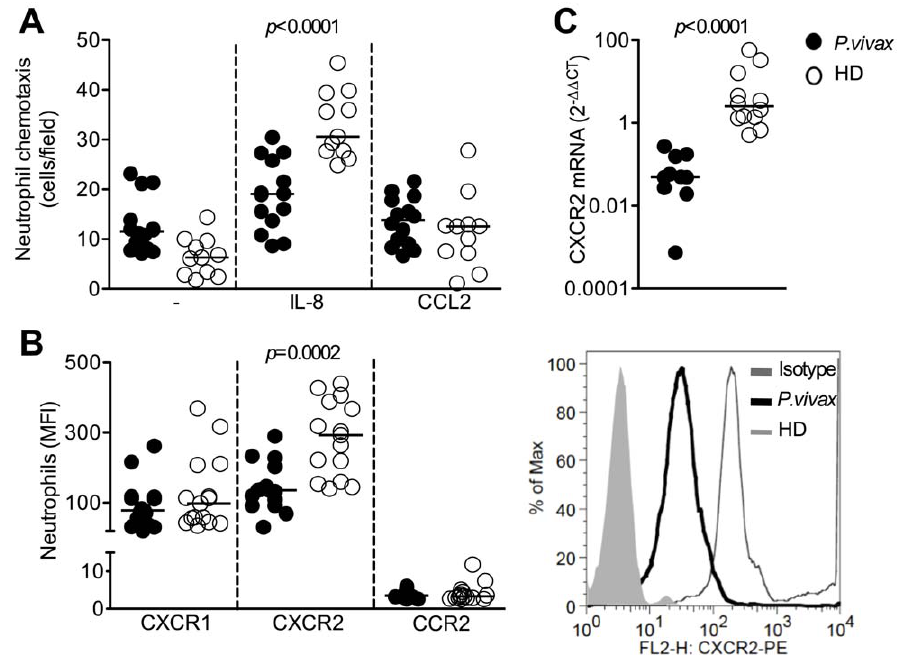
Figure 5. Malaria impairs neutrophils response to CXCR1 and CXCR2 ligand. Neutrophils were isolated from P. vivax -infected patients (closed circles; n=15) or healthy donors (open circles; n=15), and chemotaxis towards IL-8 (CXCL8) and CCL2 was assessed (A). MFI of CXCR1, CXCR2 and CCR2 on neutrophils were evaluated by flow cytometry and representative histograms of CXCR2 expression are shown (B). CXCR2 message was measured by qPCR (C). Significant differences are indicated with p -values using unpaired t test or Mann-Whitney test when a normality test failed.